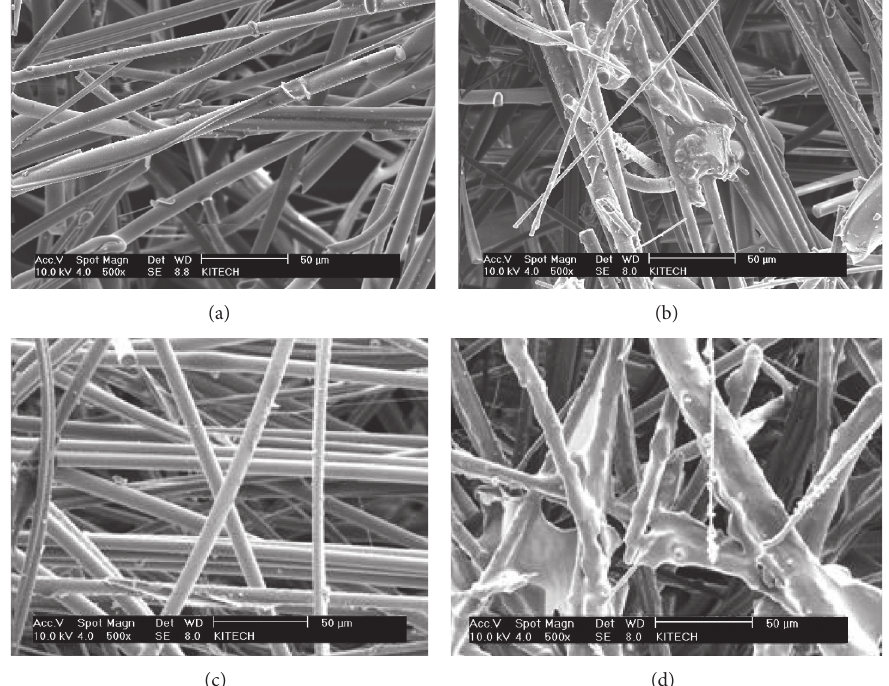
Figure 5: SEM of mineral wool and Glass wool: (a) mineral wool; (b) mineral wool coated with SH-AF; (c) glass wool; (d) glass wool coated with SH-AF.